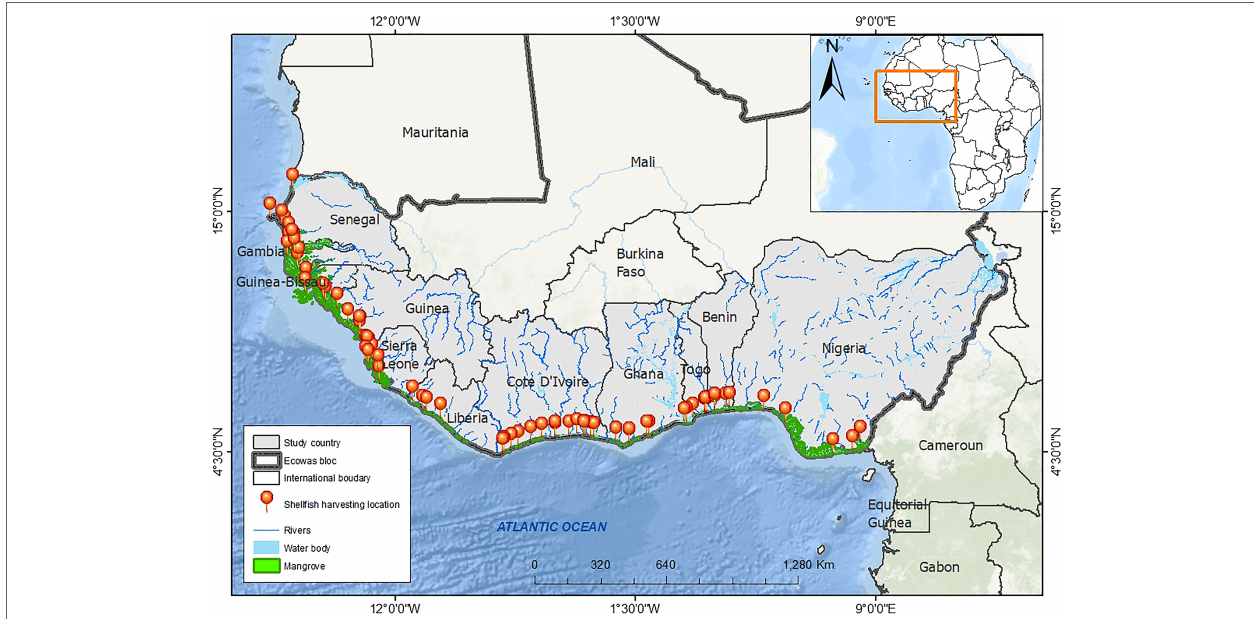
FIGURE 1 | Coastal countries of the Economic Community of West African States where estuarine and mangrove ecosystem-based shellfisheries are located. These areas present continental rivers, entering the Atlantic Ocean, with mangrove shores. [The map was developed originally by this study. Data sources: Shellfishing location points from this study; Mangrove data from Global Mangrove Watch; Africa Administrative Level 2 shape file from the Intergovernmental Authority for Development Climate Prediction and Application Centre Geoportal; Rivers data from Diva